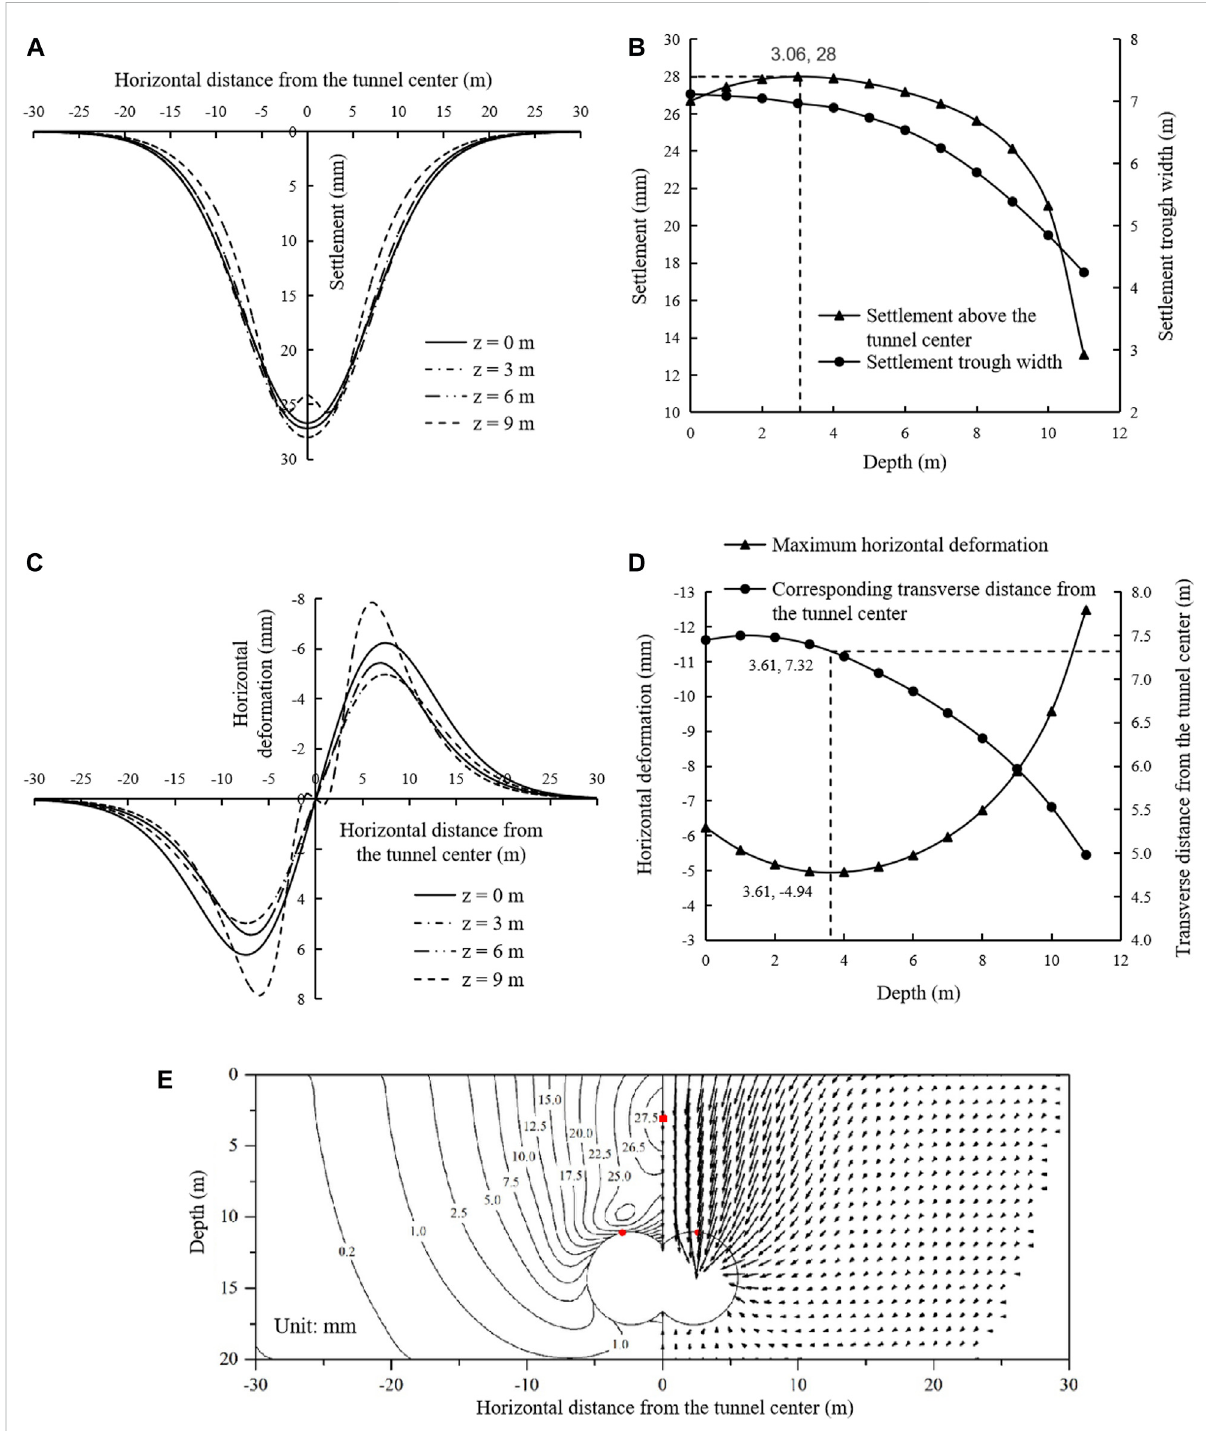
FIGURE 10 Soil deformations at R100 induced by DOT shield tunneling: (A) settlement curve; (B) characteristic settlement parameters; (C) horizontal deformation curve; (D) maximum horizontal deformation and position; (E) Soil deformation fi